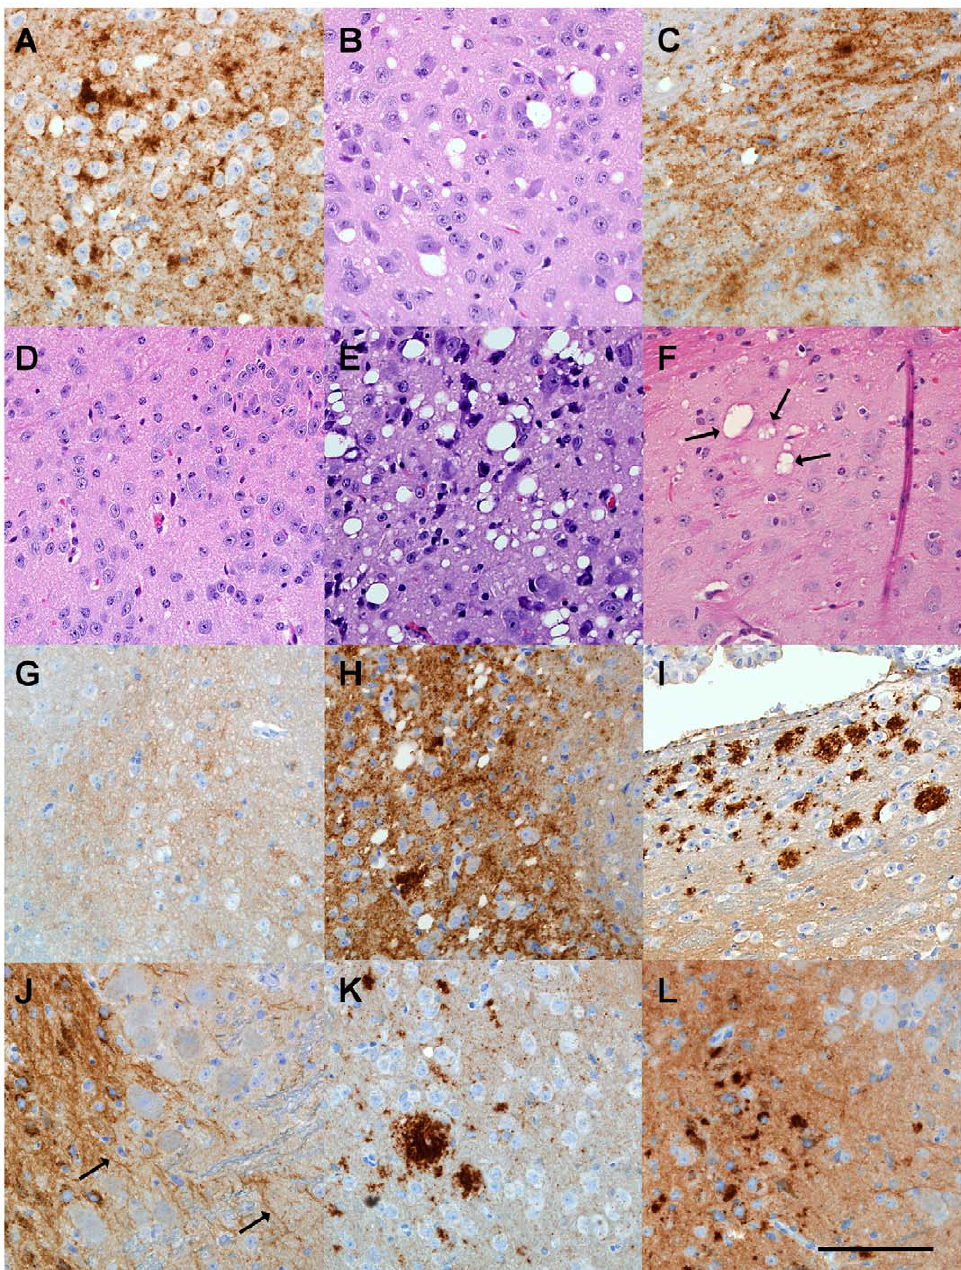
Figure 3. Histopathological analysis of brain tissue from transgenic mice inoculated with various scrapie strains. (A) (B) ME7- inoculated transgenic mouse with clinical signs at 98 dpi showing cerebral cortex with extensive PrPres deposition by D13 staining (A) and vacuolation by H&E staining (B). (C) 22L-inoculated transgenic mouse with clinical signs at 123dpi showing PrPres deposition in hypothalamus. (D) H&E stained area of pons from control uninoculated 465 day old mouse. (E) Vacuolation of pons in 79A-inoculated transgenic mouse with clinical disease at 545dpi. (F) Several pleomorphic and multiloculated vacuoles (arrows) seen by H&E staining in anterodorsal area of thalamus of RML- inoculated mouse at 603dpi. Vacuoles were not seen in other brain regions of this mouse. Mouse was negative for clinical signs and for PrPres by immunoblot. (G) D13 anti-PrP staining of pons from a 465 day old uninoculated control mouse. Note light brown PrPsen staining in background. (H) D13-stained pons from a 79A-inoculated mouse positive for clinical signs and PrPres by immunoblot at 545 dpi. Localized areas with similar stained aggregates were also seen in the thalamus, hypothalamus and hippocampus of this mouse. (I) D13-positive PrPres in anterodorsal area of thalamus of an RML-inoculated mouse negative for both PrPres by immunoblot and clinical signs at 603 dpi. Deposits were not detected in other brain regions. Light staining in lower part of panel is PrPsen which was also seen in uninoculated mice. (J) Positive D13 staining around cells and along linear structure of extracellular space or possibly axons (arrows) in pons from an RML-inoculated mouse negative for both PrPres by immunoblot and clinical signs at 545dpi. No other brain regions had detectable staining. (K) Stained PrPres aggregates in anterodorsal thalamus from 79A-inoculated mouse negative for clinical signs and for PrPres by immunoblot at 545dpi. Similar aggregates were also seen in the pons. (L) Stained PrPres aggregates in pons from a 79A-inoculated mouse negative for clinical signs and for PrPres by immunoblot at 545 dpi. PrPres was detected only in a small area of the pons. Diffuse staining in background is PrPsen. Scale bar is 100 m m and applies to all panels.